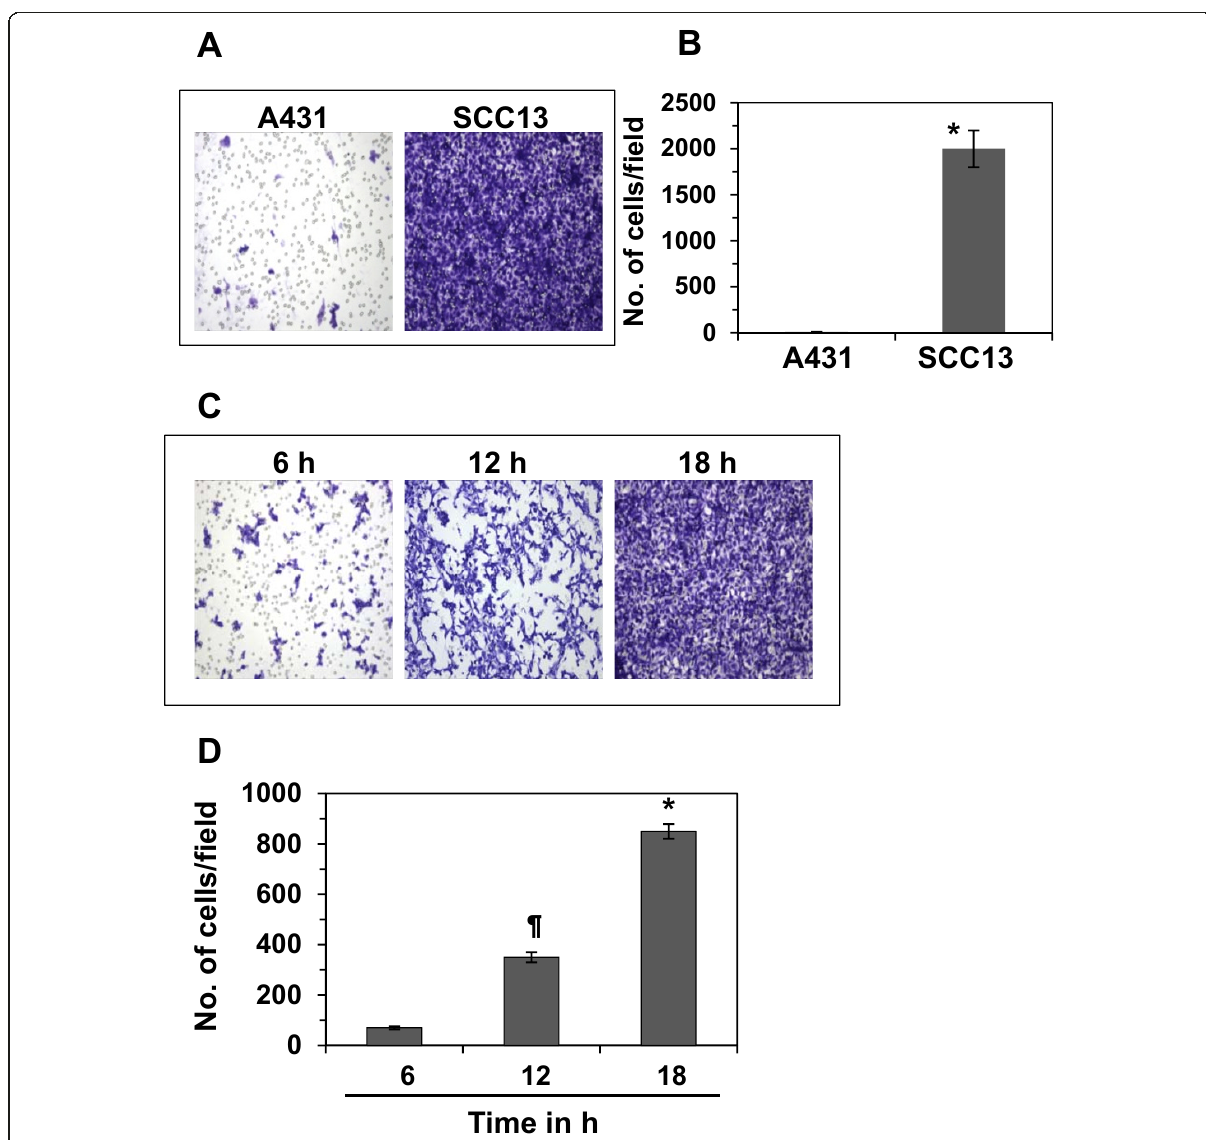
Figure 1 Comparative cell invasion ability of human cutaneous squamous cell carcinoma cells . (A) Invasive ability of human epidermoid carcinoma cells (A431) and head and neck cutaneous squamous cell carcinoma cells (SCC13) were compared. Equal numbers of cells were subjected to cell invasion using standard Boyden chamber assay. Twenty-four h later, invasive cells were detected on the membrane after staining with crystal violet. (B) The number of invasive cells were counted and the results expressed as the mean number of invasive cells ± SD/ microscopic field (n = 3). Significantly higher versus A431 cells, * P < 0.0001. (C) Time-dependent cell invasion potential of human head and neck cutaneous SCC cells. (D) The invasive cells were counted and the results expressed as the mean number of invasive cells ± SD/microscopic field. Significant higher invasion of cells versus 6 h time point, * P < 0.001; ¶ P <